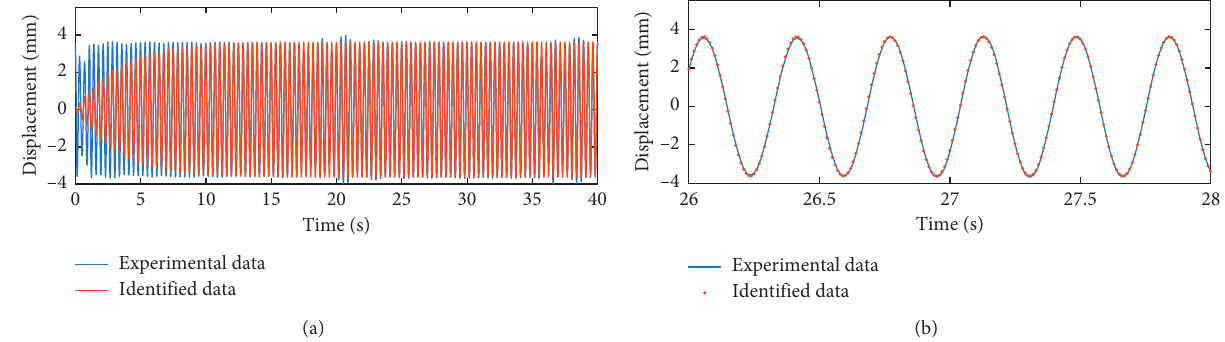
Figure 3: Comparison of the experimental displacement with the identified result. (a) Identified and experimental displacement responses. (b) Magnification of a part of Figure 3(a) from 26s to 28s.